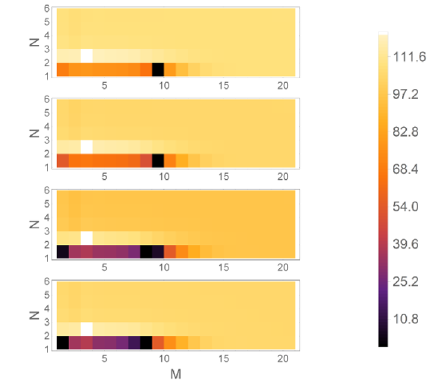
Figure 3 . Rescaled values of Y (2 N;M ) ( t ) for (cid:17) = 0 and di(cid:11)erent f N; M g at t = 4 ; 3 : 5 ; 2 ; 0 : 4 (from top to bottom). The rescaled value of Y (2 N;M ) ( t ) is de(cid:12)ned as Y (2 N;M ) ( t ) =a 0 = 1+ P 6 strongest bounds are given by small N and M .